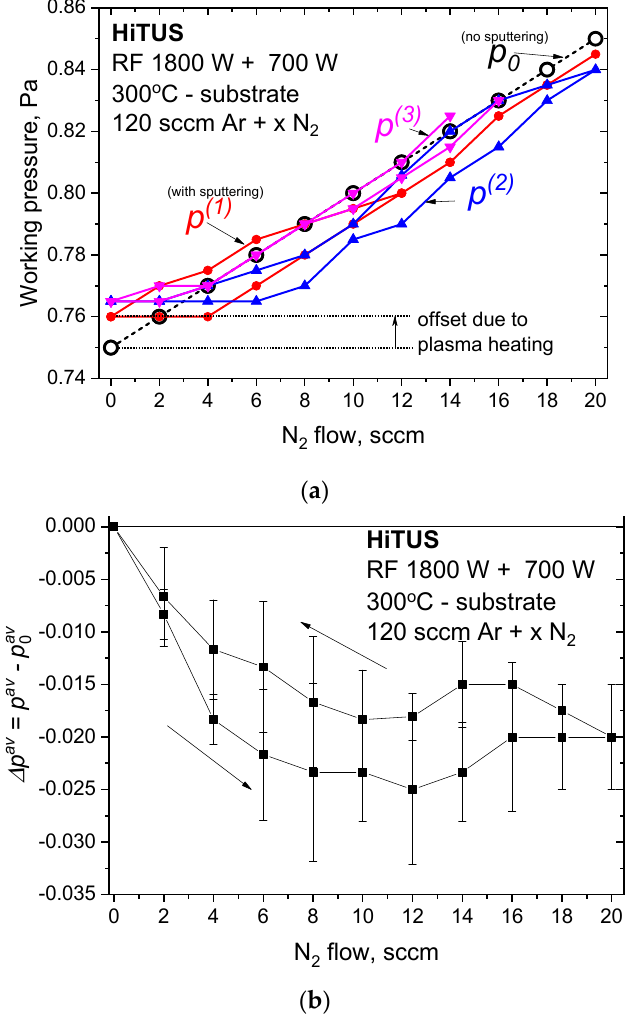
Figure 1. ( a ) Changes in working pressure in the deposition chamber due to nitrogen additions into the Ar sputtering atmosphere without ( p 0 ) and with the power of RF 700 W applied to TiNbVTaZrHf target during three independent nitrogen flow cycles ( p (1) , p (2) , p (3) ) (the offset of pressure at 0 sccm N 2 after turning sputtering on is an artifact attributed to plasma heating); ( b ) average pressure difference ∆ p av = p av − p 0 resulting from nitrogen consumption.